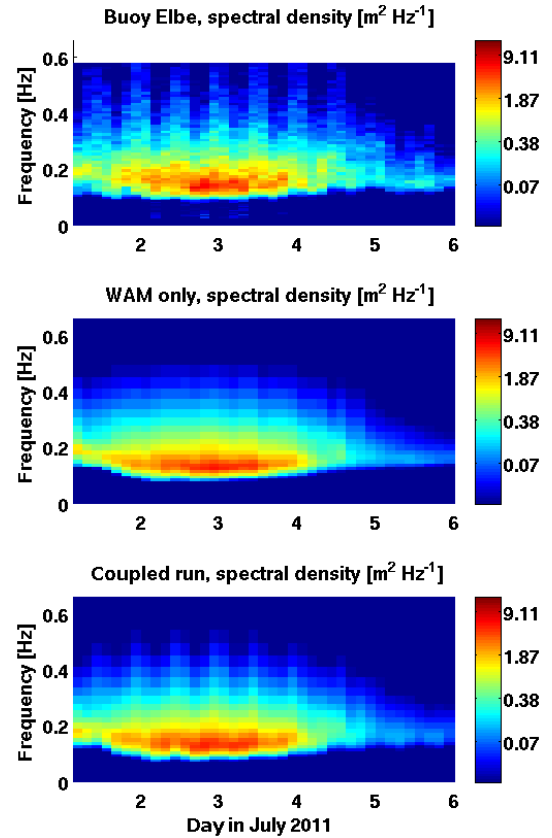
Figure 3. Comparison of measured (top) and computed values of the spectral energy density at the buoy Elbe (see Fig. 1 for its loca-